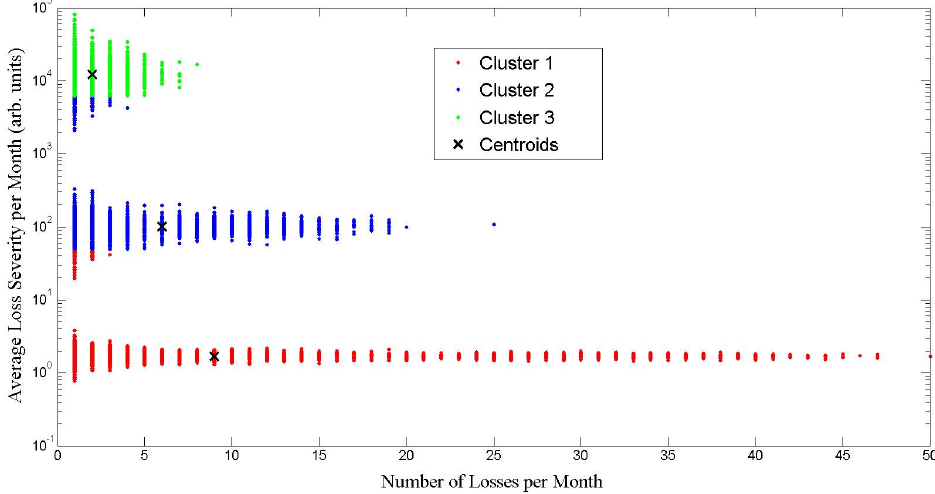
Figure 4. DPFS for Scenario (I); three distinct regions are found between frequency and severity; centroids are marked with an “x”. The clustering algorithm finds the low severity region which consists of high/medium/low frequencies in Cluster 1 as simulated in Scenario (I). In Cluster 2, the medium severity region consisting of medium/low frequencies is noted by the clustering method. Finally, in Cluster 3, the high severity region consisting of low frequencies only is found.